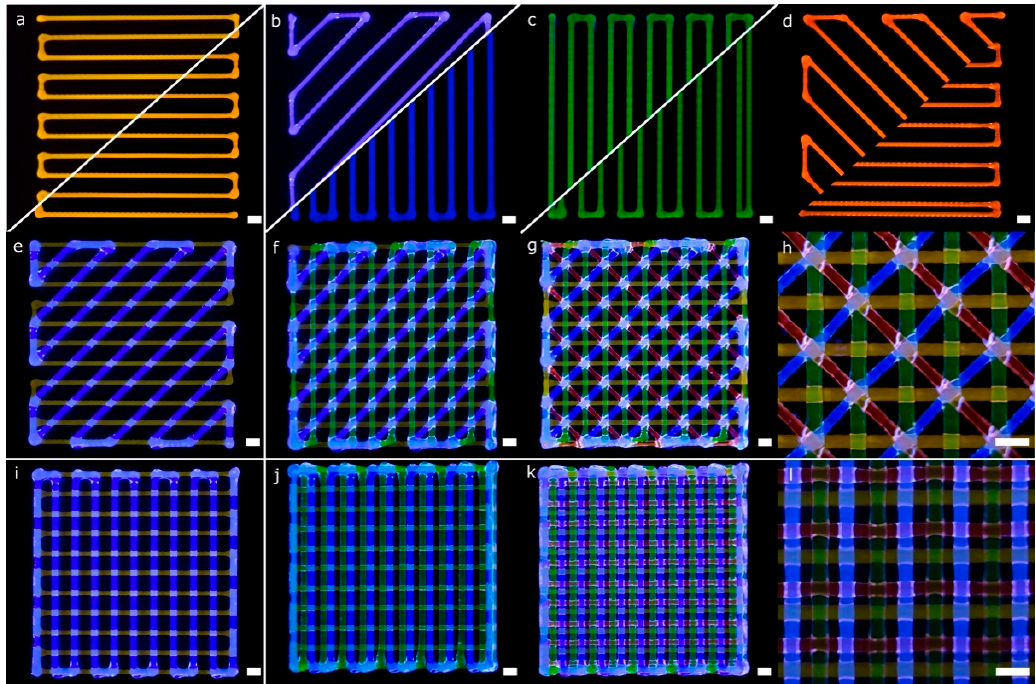
Figure 11. Pictures of a complex porous structures printed using four printheads with parallel and diagonal rectilinear patterns. Each fluorescent bioink was deposited in a different layer ( a – d ) with a total of four layers stacked ( e – g , i – k ). Detailed view of the diagonal ( h ) and perpendicular lattice structures ( l ); scale bars: 1 mm.